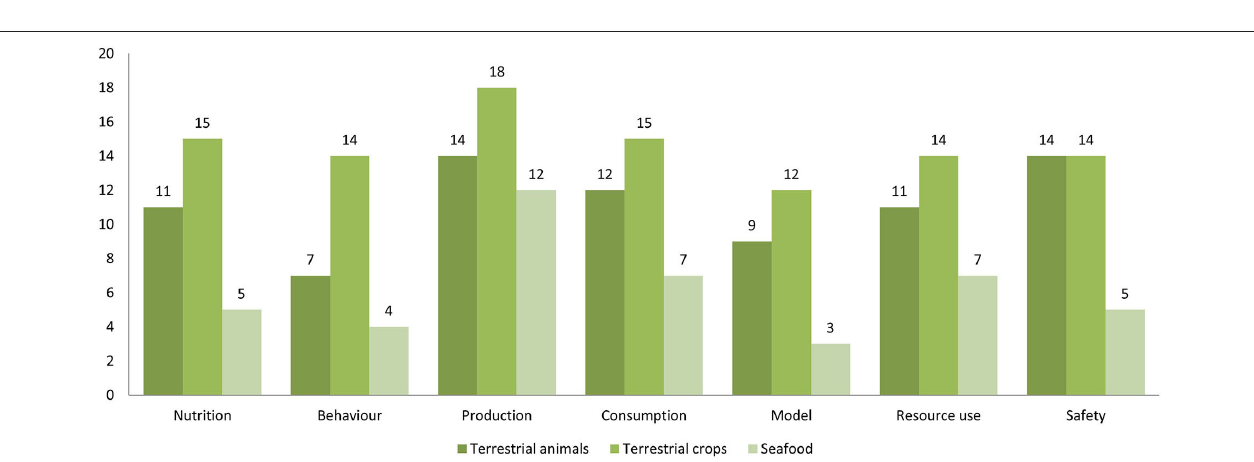
FIGURE 2 | Number of papers mentioning each food category five or more times, by theme.